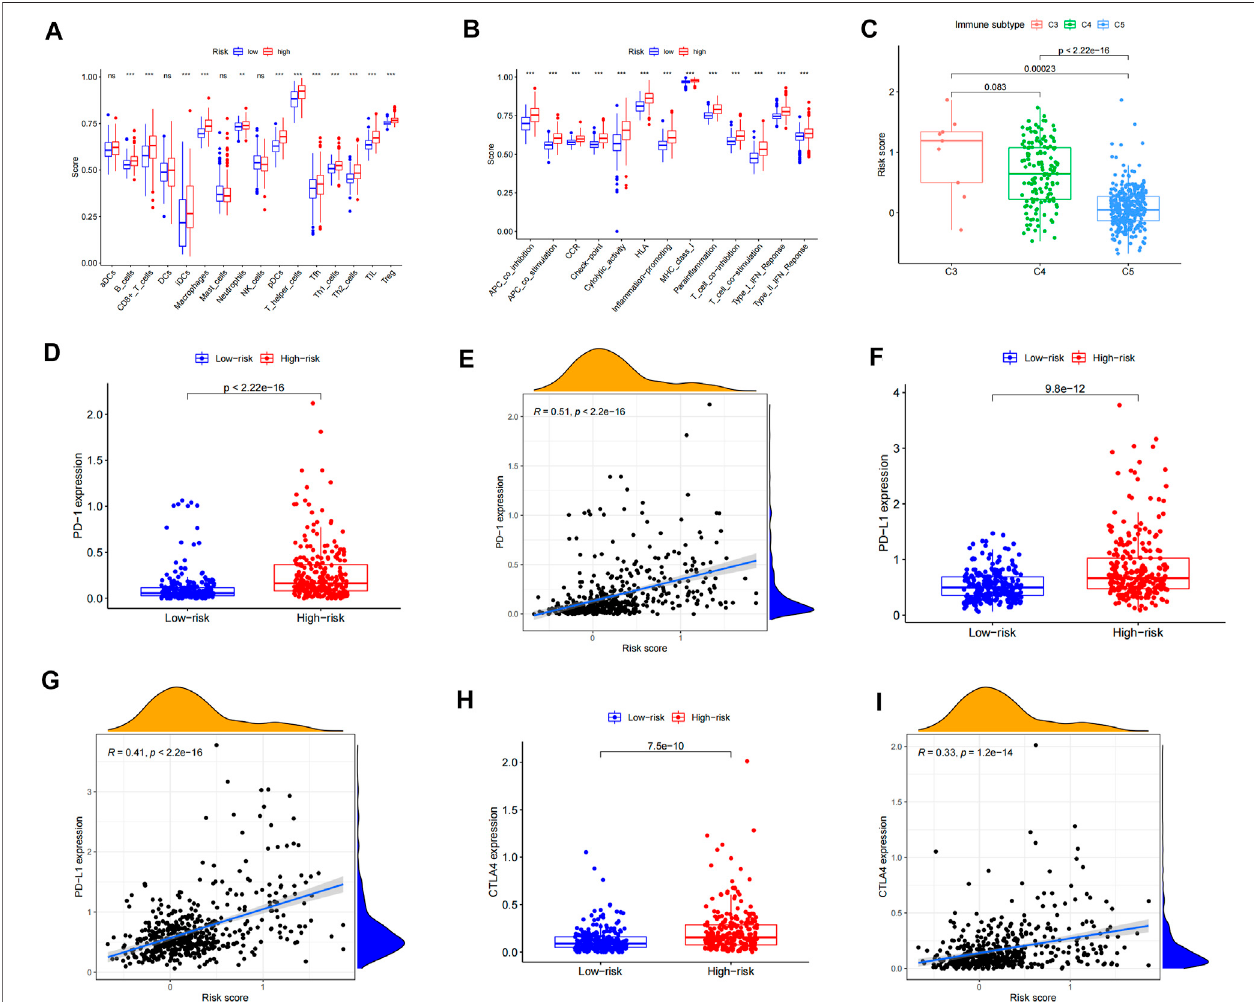
FIGURE 5 | Correlation analysis of the immune in fi ltration pattern. (A) Differences of immune cell subsets in high- and low-risk groups of an in fl ammation-related prognosis model. (B) The difference of the immune function and pathway in the high- and low-risk groups of in fl ammation-related prognosis models. (C) The difference betweenLGGpatientswithdifferentriskvaluesandimmuneclassi fi cation. (D) TheexpressiondifferenceofPD-1inLGGhigh-andlow-riskgroups. (E) ScatterplotofPD- 1 correlation with the risk score. (F) Expression difference of PD-L1 in LGG high- and low-risk groups. (G) Scatterplot of PD-L1 correlation with the risk score. (H) The expression difference of CTLA4 in LGG high- and low-risk groups. (I) Scatterplot of CTLA4 correlation with the risk score.